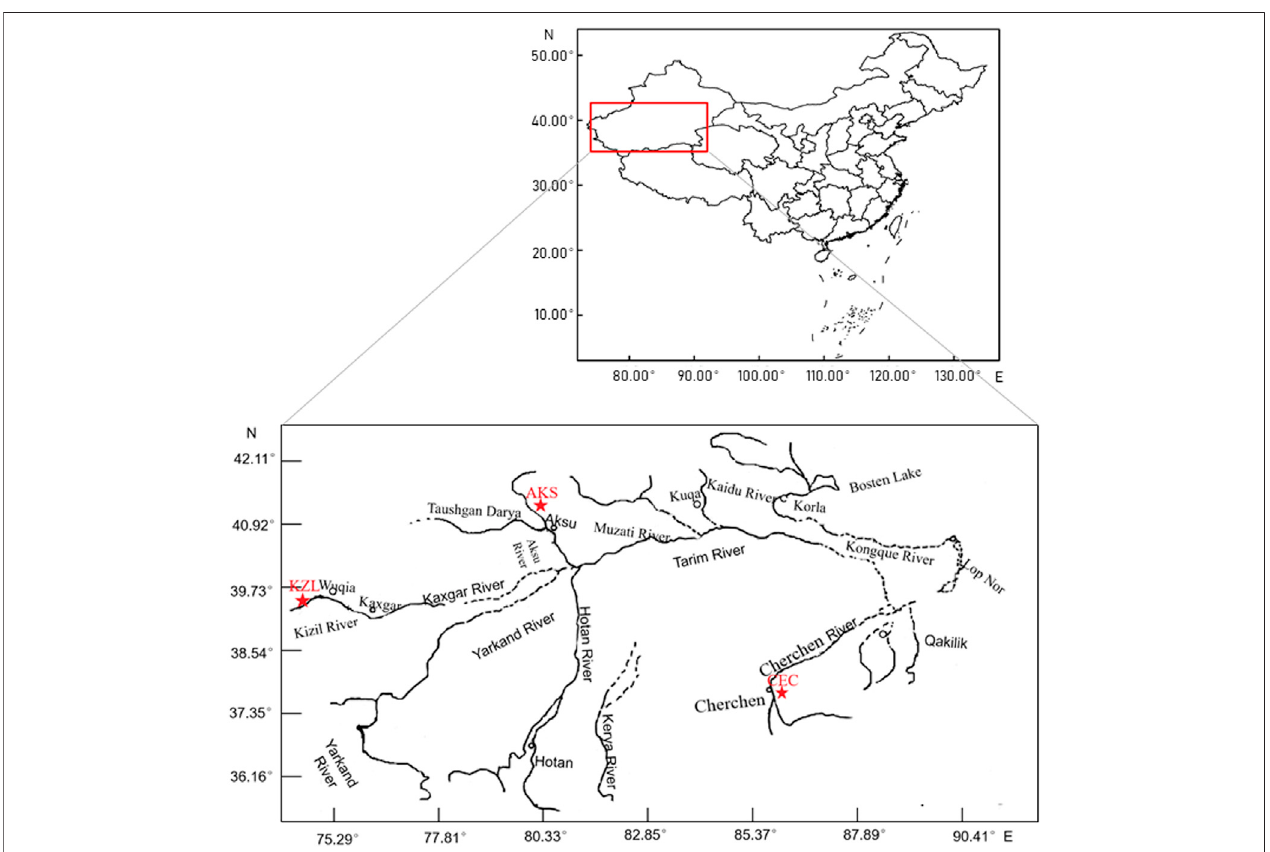
FIGURE 1 | Population sampling sites of Schizothorax biddulphi . + : each sampling point.